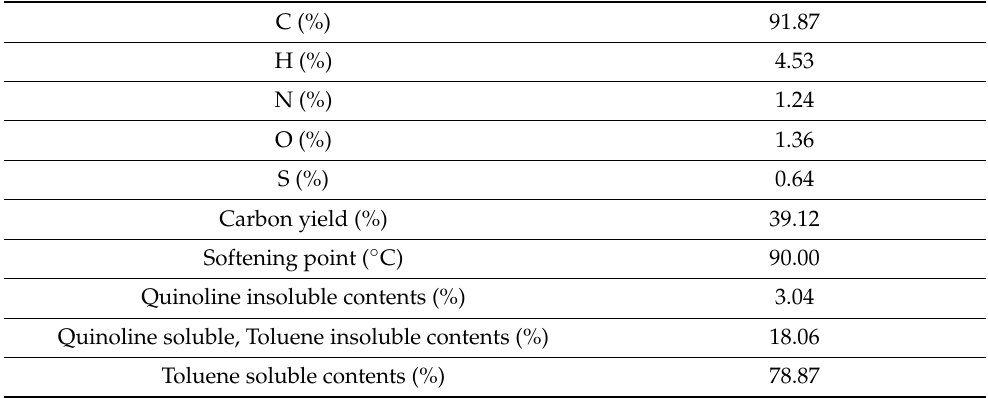
Table 1. Impregnation pitch